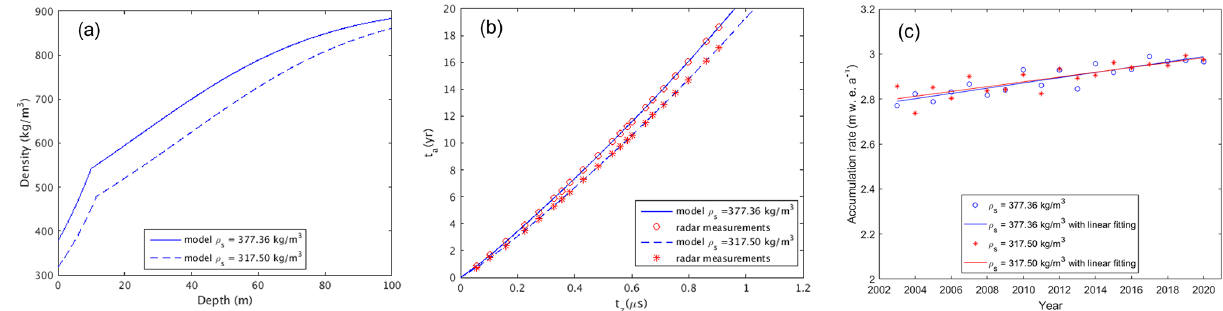
Figure 10. Depth–density profiles (a) , snow layer depositional ages (b) , and estimated annual accumulation rates (c) for two different surface density values.